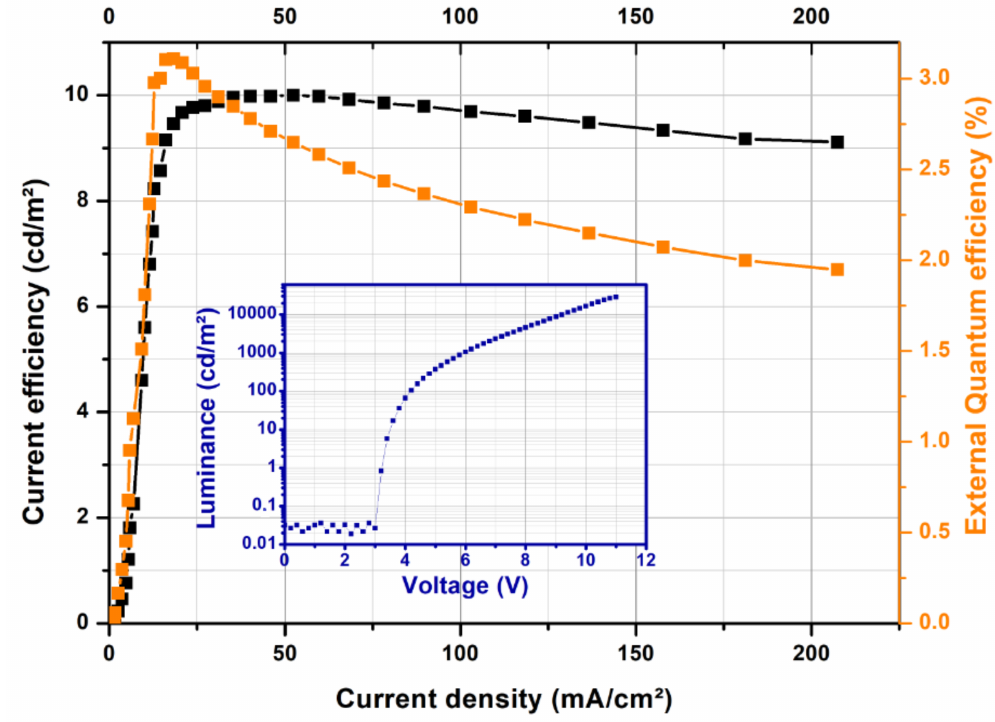
Figure 6. Current and external quantum efficiencies vs. current density characteristics for type C-OLEDs.